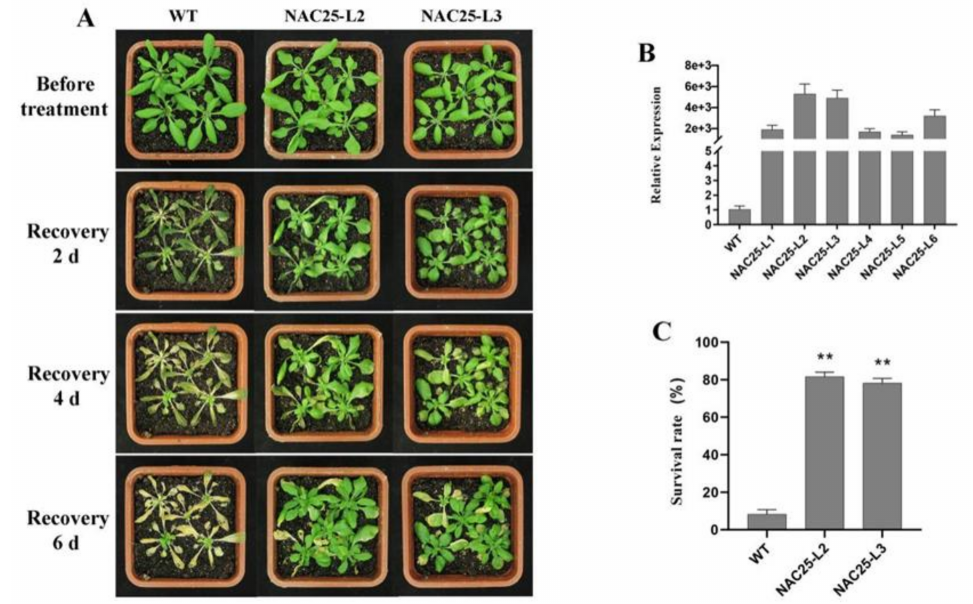
Figure 9. Overexpression of HuNAC25 in Arabidopsis enhanced freezing tolerance. ( A ) performance and ( C ) survival rates of WT and HuNAC25 transgenic plants after freezing; ( B ) expression levels of HuNAC25 in WT and transgenic plants. AtACTIN2 was used as an internal control. Twenty seedlings per transgenic line were used in each freezing treatment. Data represent average values from three biological replicates ( ± S.D.). Asterisks indicate significant differences (** p < 0.01) between the transgenic lines and WT plants.